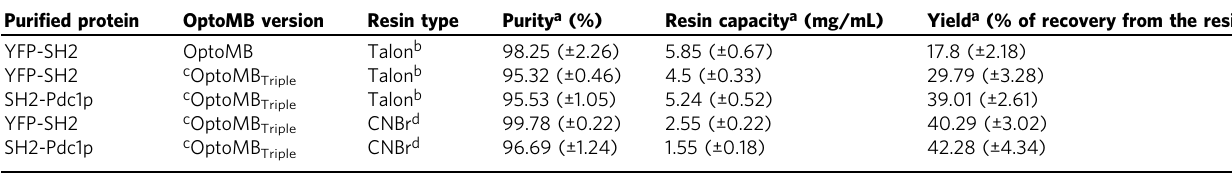
Table 2 Puri fi cation parameters of LCAC batch experiments. Puri fi ed